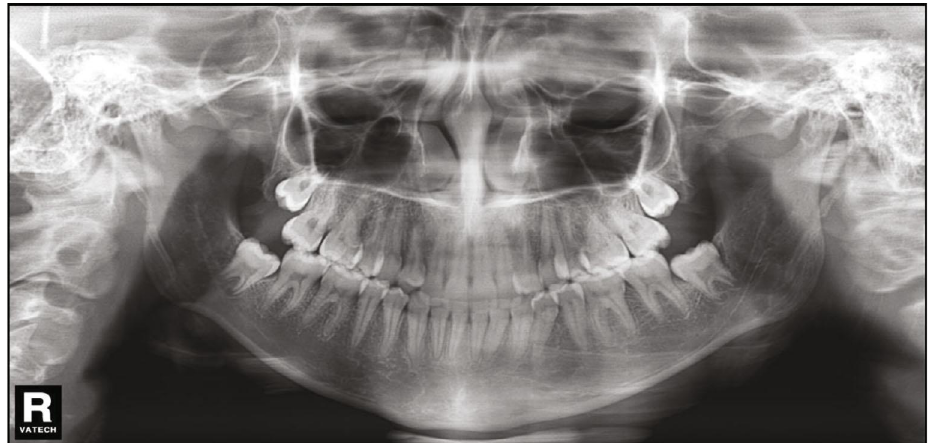
Figure 16: Posttreatment panoramic